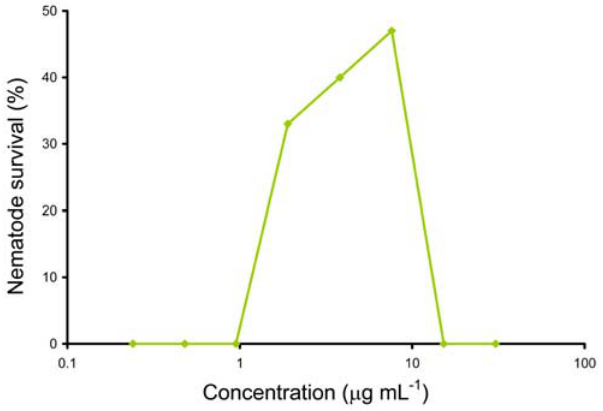
Figure 5. Dose-response of infected worms to malachite green carbinol base indicating toxicity beyond the EC 50